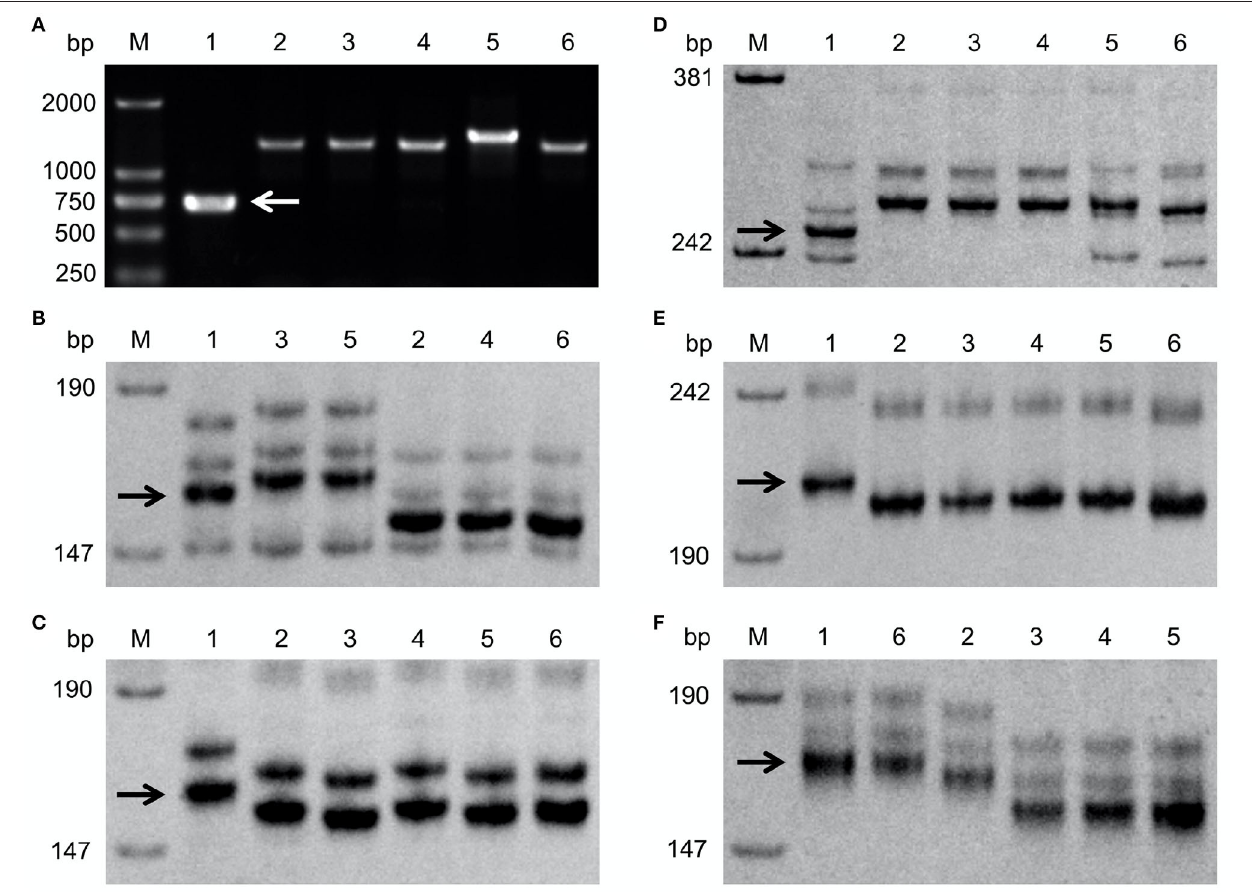
FIGURE 1 | Detection of Fhb1 by WGRB619 (A) , Fhb4 by GWM149 (B) and GWM513 (C) , and Fhb5 by MAG9482 (D) , BARC180 (E) , and WMC752 (F) . The target bands were indicated by arrows. M: the DNA size standard (in bp). 1, 2, 3, 4, 5, and 6: NMAS022, Bainong418, Bainong4199, Zhoumai27, 4446, and Chuanmai 64,